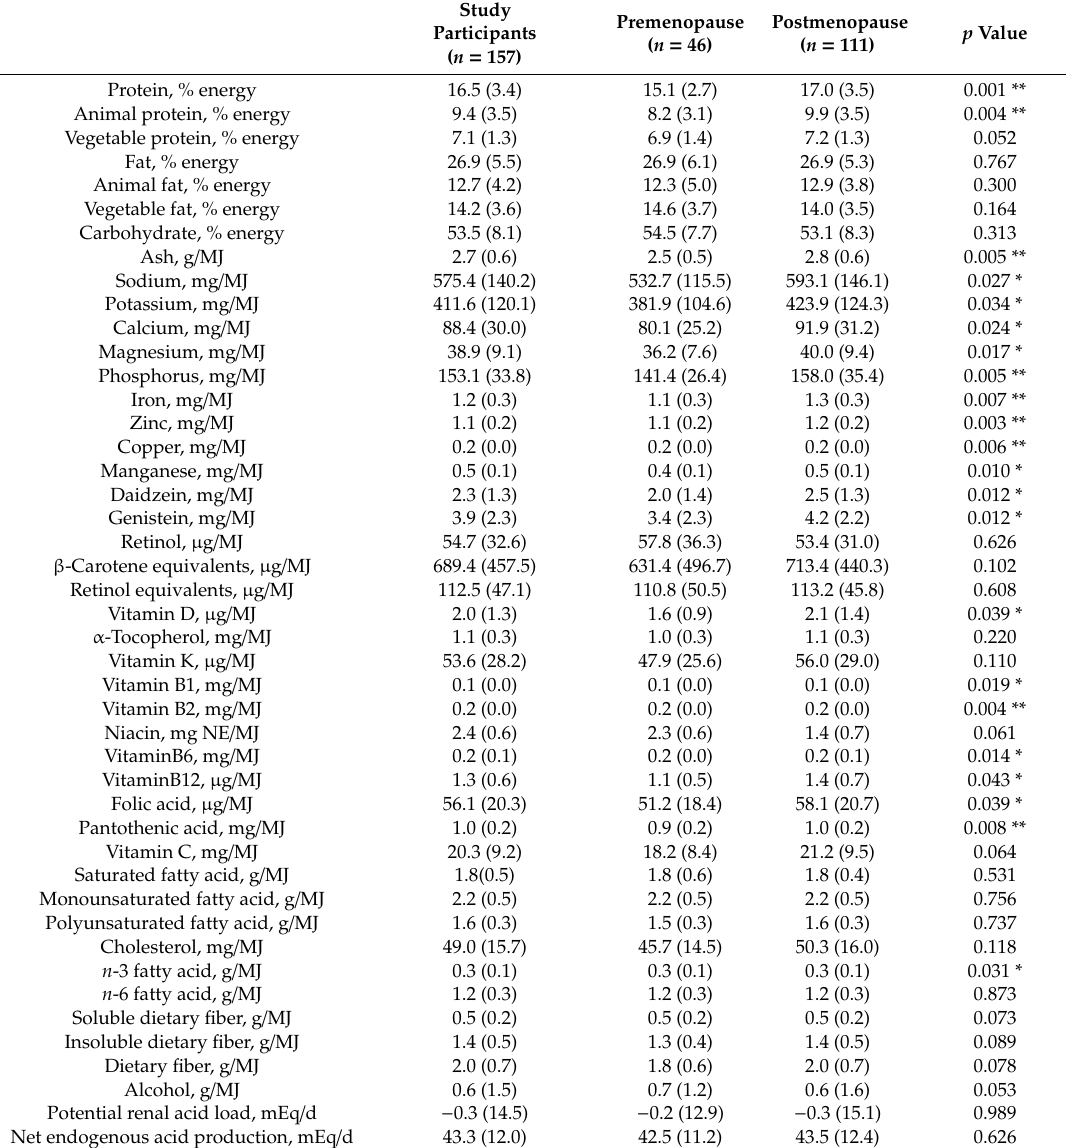
Table 1. Consumption of 43 nutrient factors and dietary acid load in the study